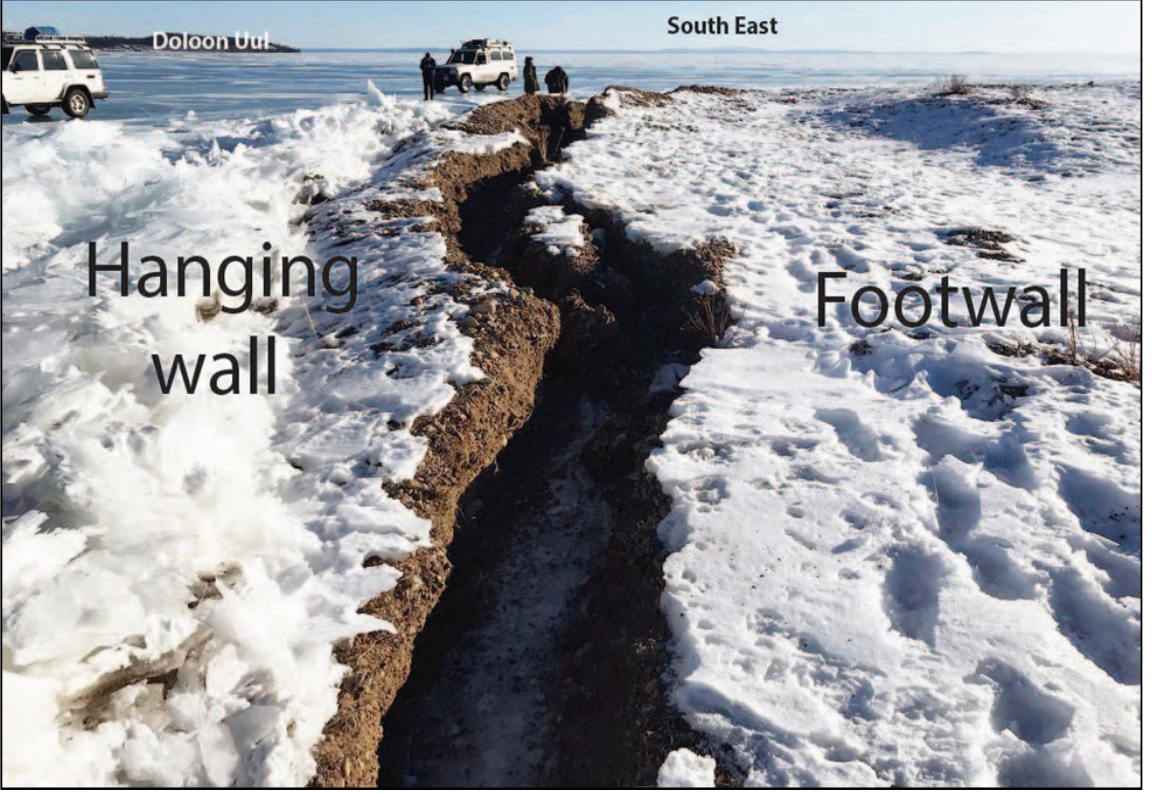
Fig. 4. A photograph for the big crack. The width of the surface rupture is ~1.3 m. Photo by